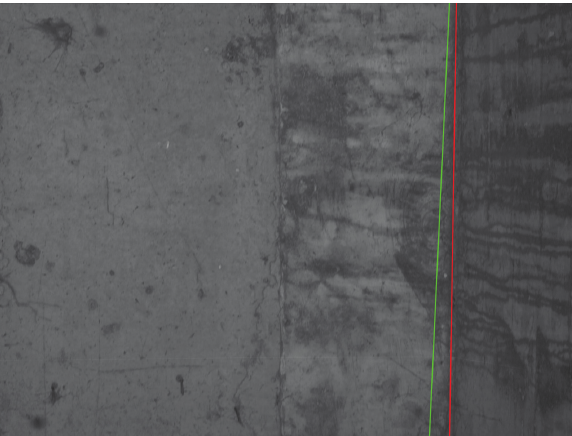
Figure 8: An example of the extracted structure lines based on image intensity (Green Line) and 3D point clouds (Red